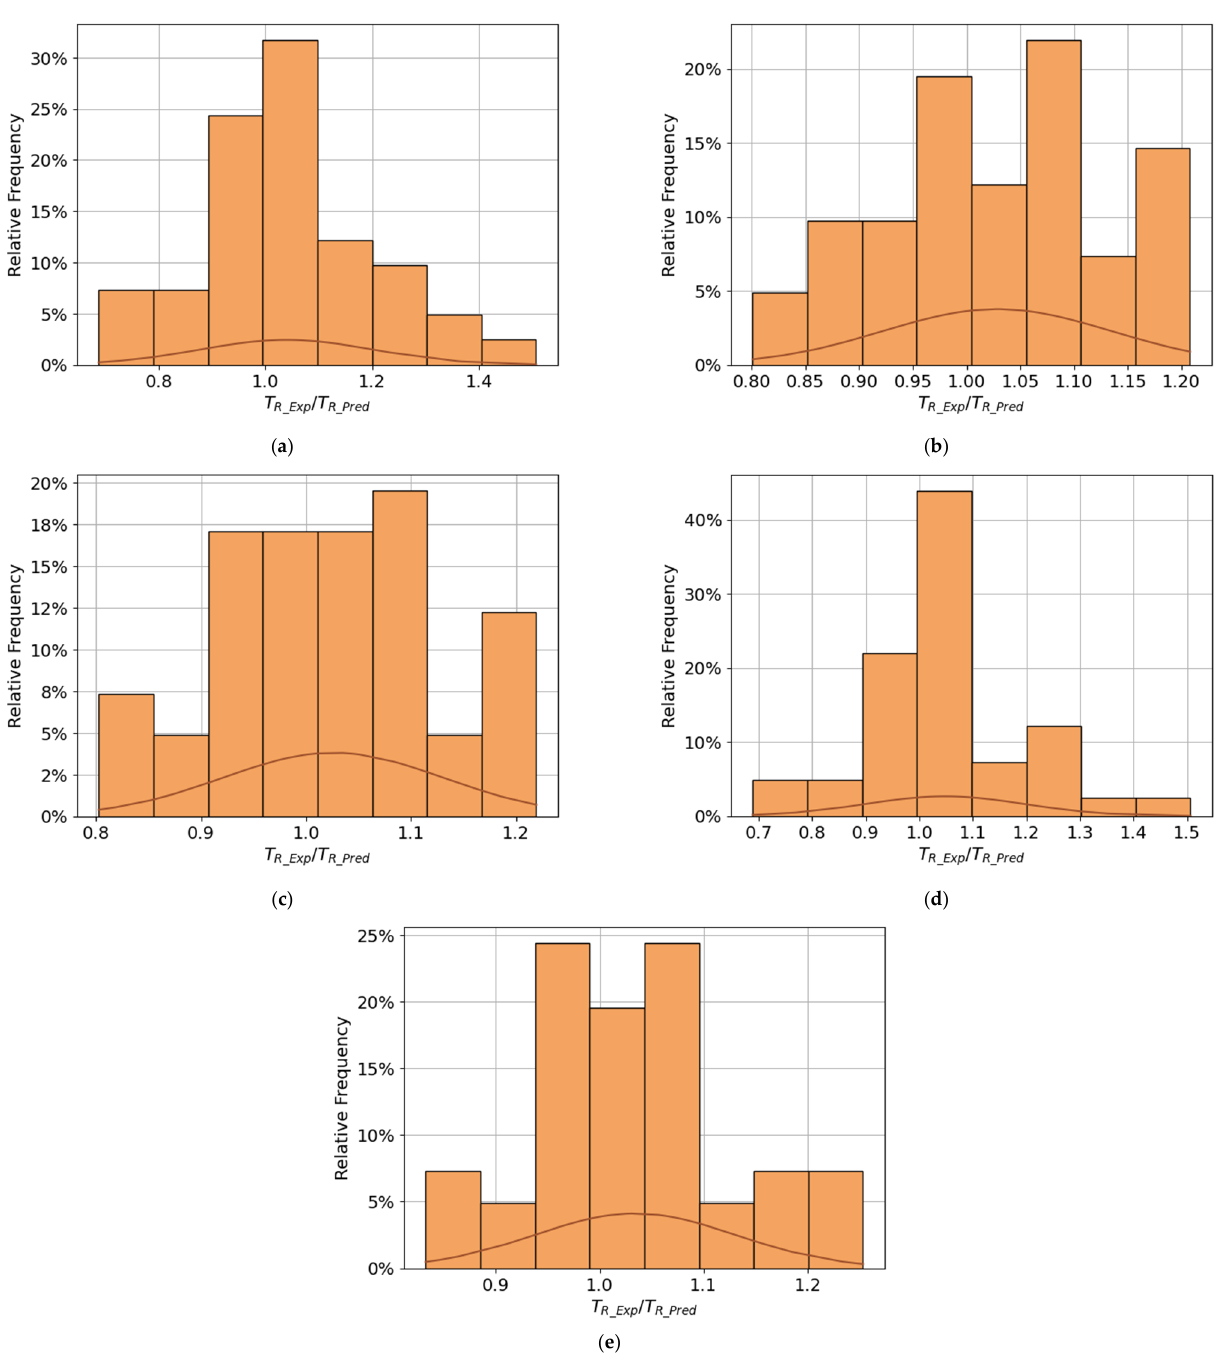
Figure 10. Histogram for T R_Exp / T R_Pred for testing results: ( a ) DT, ( b ) BME, ( c ) FRT, ( d ) AB